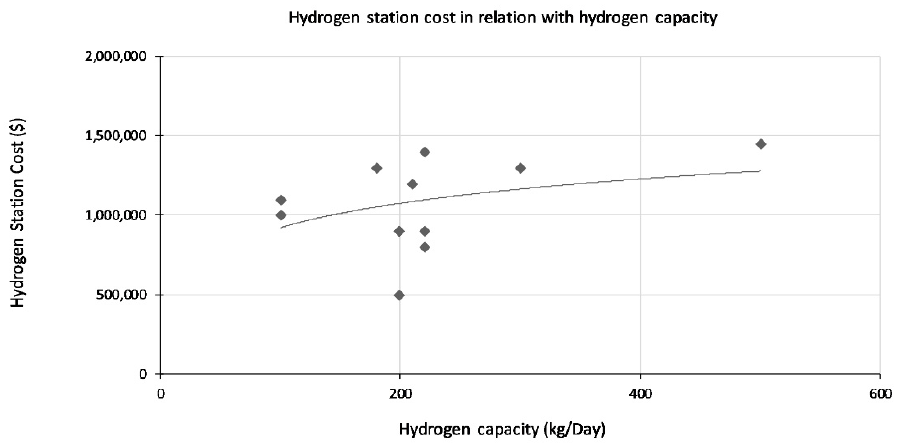
Figure 5. Effect of H 2 demand on initial investment cost [23].